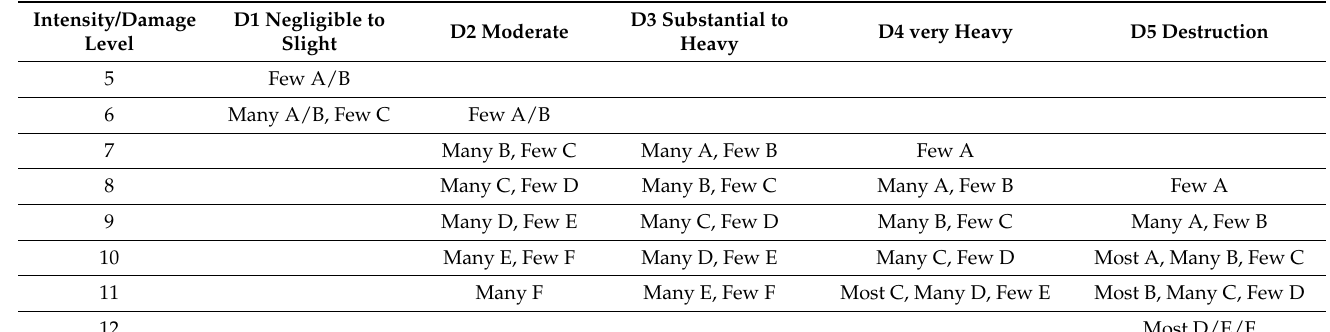
Table 2. Damage level mapping for different vulnerability classes